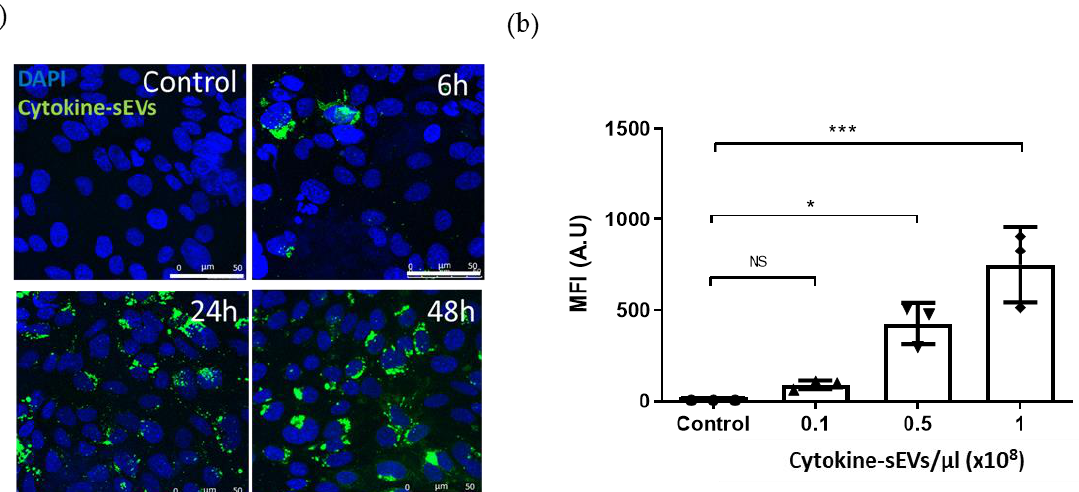
Figure 2. Characterisation of the uptake of cytokine-sEVs by naïve brain endothelium. ( a ) Confocal images of the uptake of 0.5 × 10 8 DiO-labelled cytokine-sEVs/ µ L by human microvascular brain endothelial cells (hCMEC/D3 cells) at different time points (0, 6, 24 and 48 h). ( b ) Flow cytometry measurements of DIO-labelled cytokine-sEVs incubated with hCMEC/D3. The graph shows a quantification of the median fluorescent intensity (MFI) of the uptake of cytokine-sEVs (0.1, 0.5 and 1×10 8 sEVs/µL) by naïve hCMEC/D3 cells. Data is shown as the mean ± SEM ( n = 3). The means were compared with one-way ANOVA followed by Tukey´s multiple comparison test. * p < 0.05 and *** p < 0.001 .